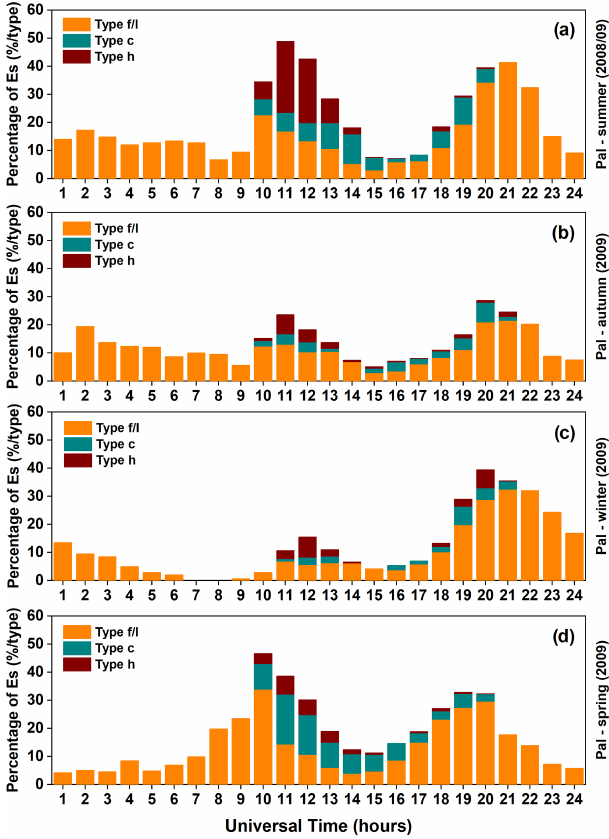
Figure 1. Temporal variation of the E s layer occurrence rates di- vided into different types over Palmas during the summer (a) au- tumn (b) , winter (c) , and spring (d) months of the year